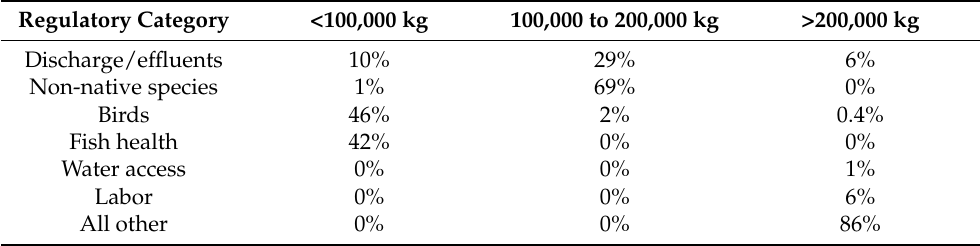
Table 16. Farm size effects of lost revenue by regulatory cost category (values in % of total lost